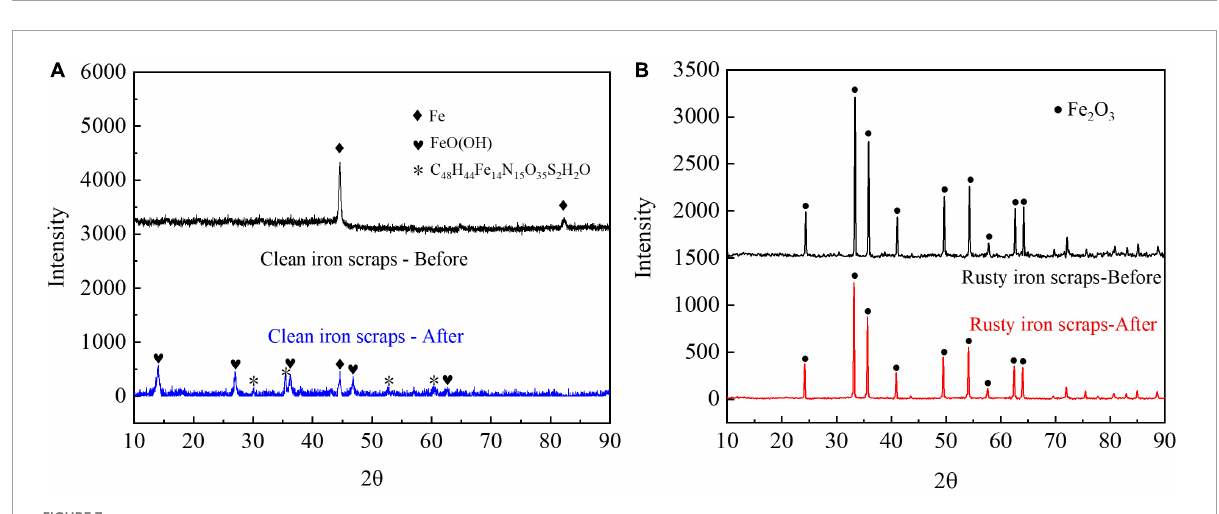
FIGURE7 XRD images: iron scraps in (A) R Clean and (B) R Rusty systems before and after